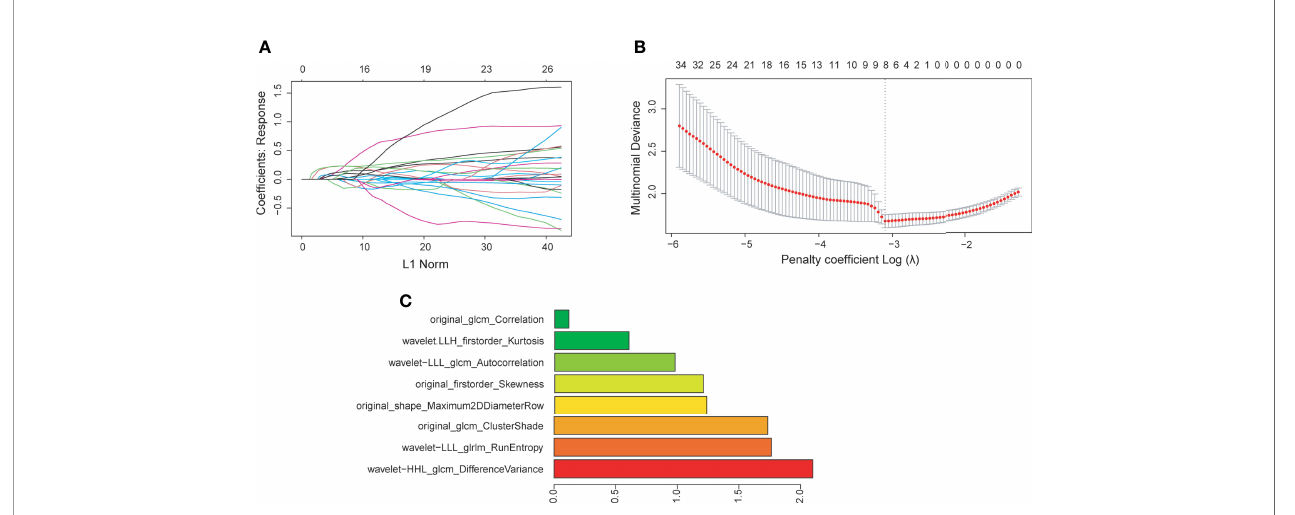
FIGURE 2 | (A) Feature coef fi cients corresponding to the value of parameter l . Each curve represents the change trajectory of each independent variable. (B) The most valuable features were screened out by tuning l using LASSO regression with 10-fold cross-validation via minimum binomial deviation. The dotted vertical line represents the optimal log ( l ) value. (C) The 8 selected radiomic features with the most discriminative value according to the best penalty parameter ( l ).